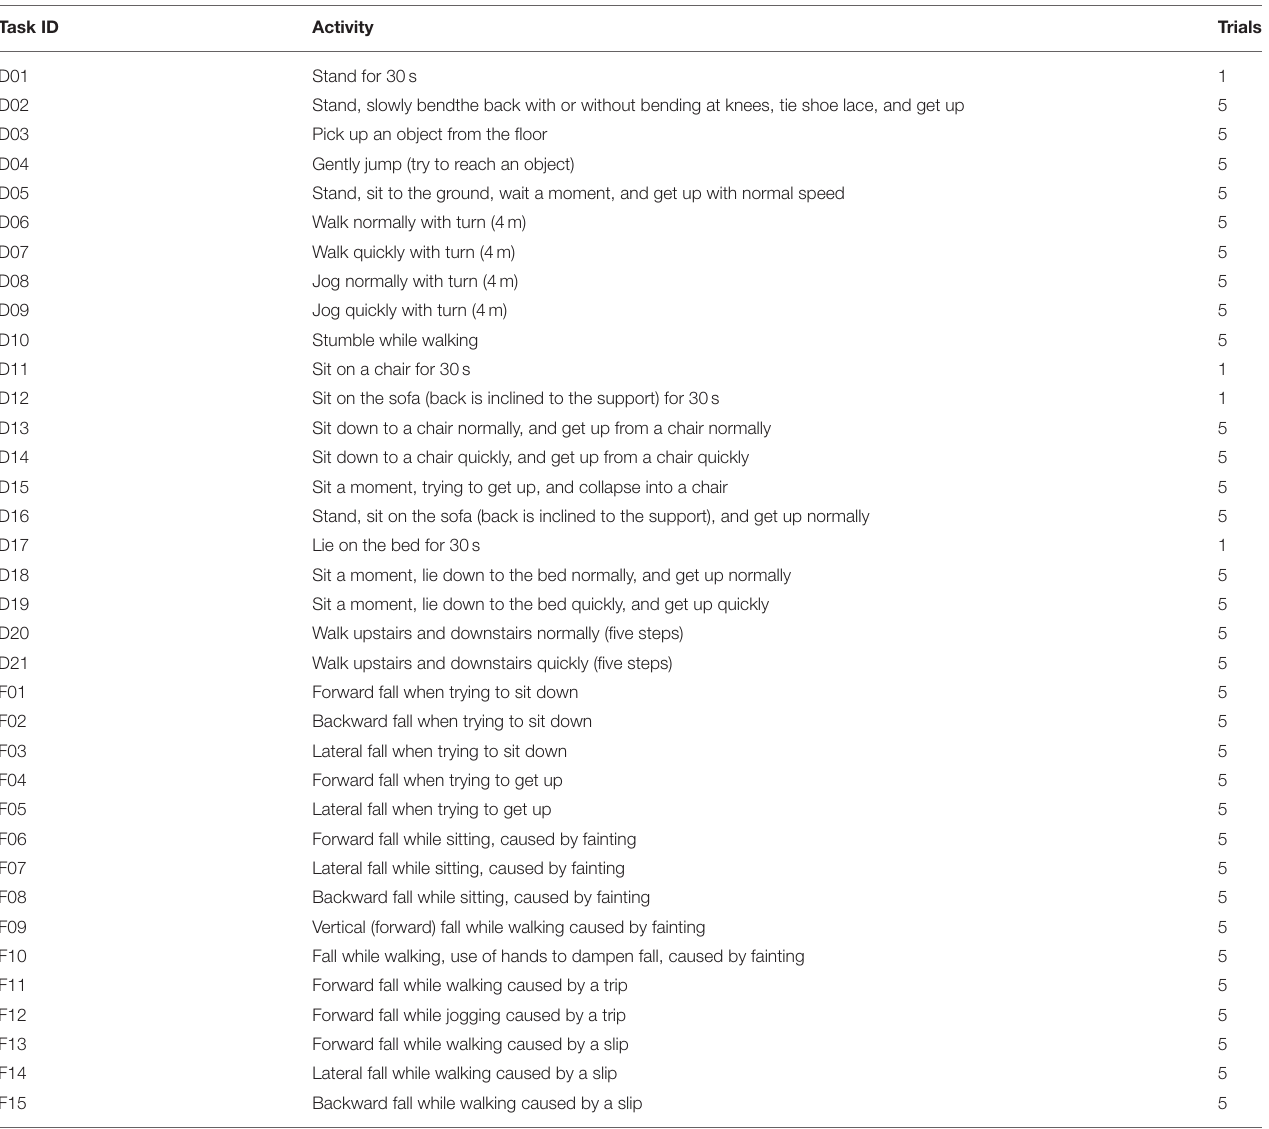
TABLE 2 | Experimental tasks of 21 types of ADLs and 15 types of falls. Task ID